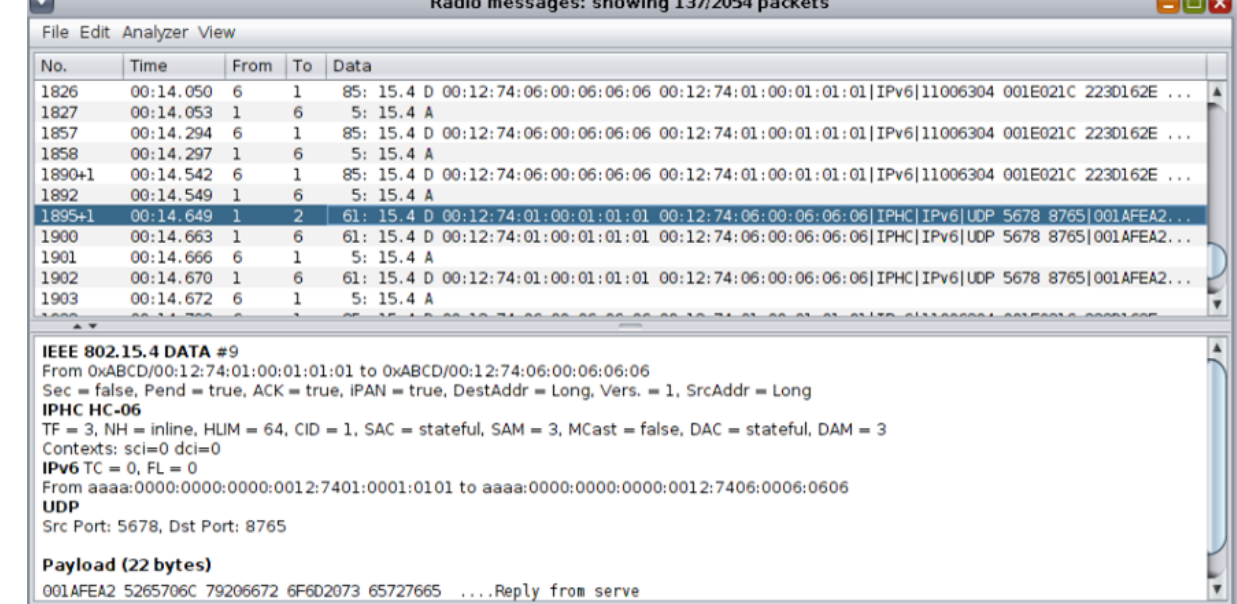
Figure 31. Network traffic information from the attack scenario in the “Radio messages” output window.